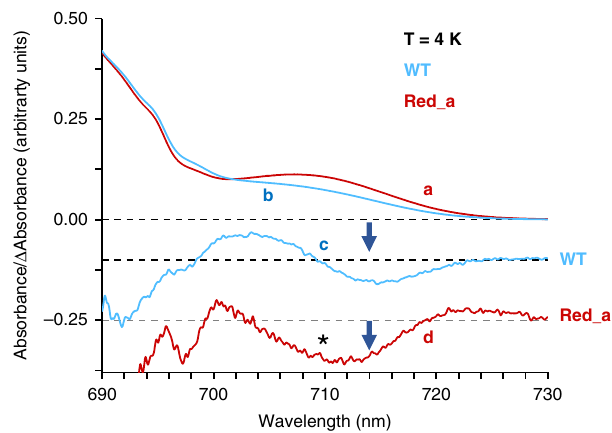
Fig. 4 B31-B32-B33 Chl trimer is the C710 trap. Spectra b (blue) and a (red) show absorption spectra of the WT and Red_a PSI complexes, respectively; recorded at T = 4 K, with a spectral resolution of 4 cm − 1 (see Supplementary fi g. 2b for the complete 4 K absorption spectra). The corresponding nonresonant holes (obtained for the burning wavelength ( λ B ) of 670.0 nm) are labeled as curves c and d , respectively (see text for details). The thick blue arrow marks a broad hole near 714 nm, indicating very ef fi cient EET to the lowest-energy C714 state in WT PSI. The Red_a PSI complex reveals less ef fi cient EET to the C714 state. As a result, the C710 state, indicated by an asterisk, is also bleached.